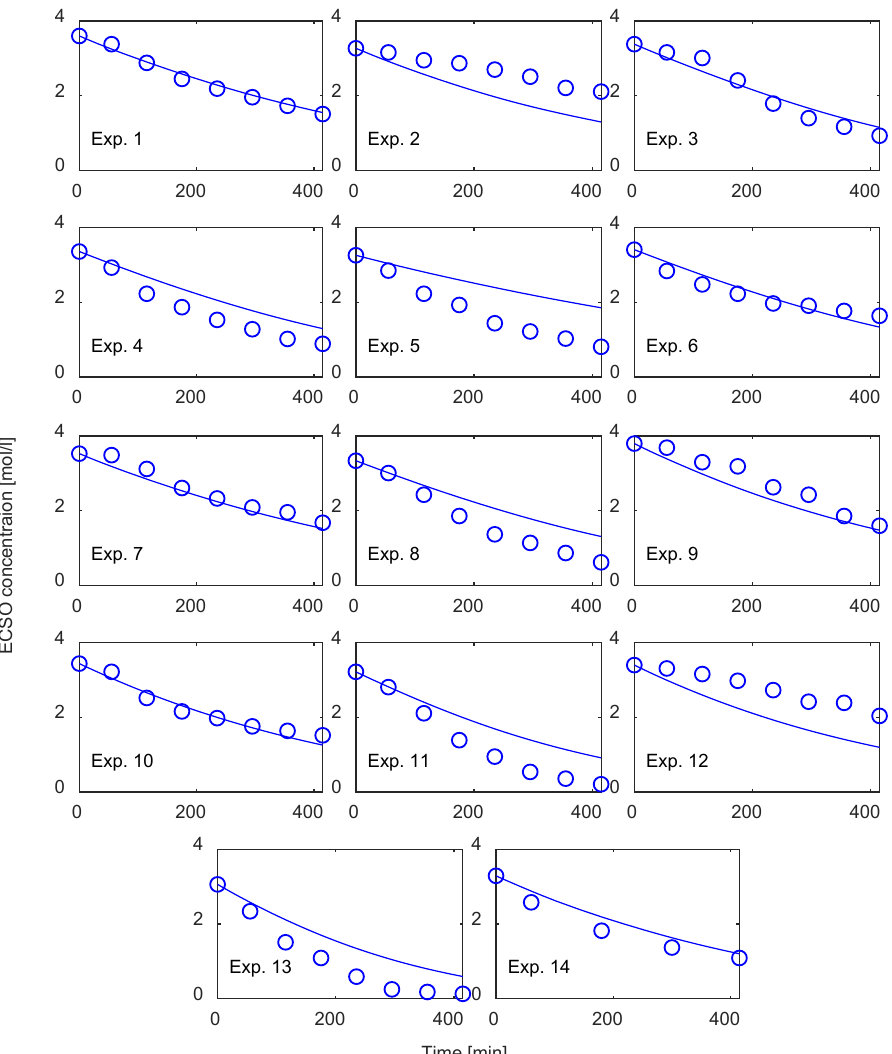
Figure 4. The comparison of the measured (marker) and the simulated results.